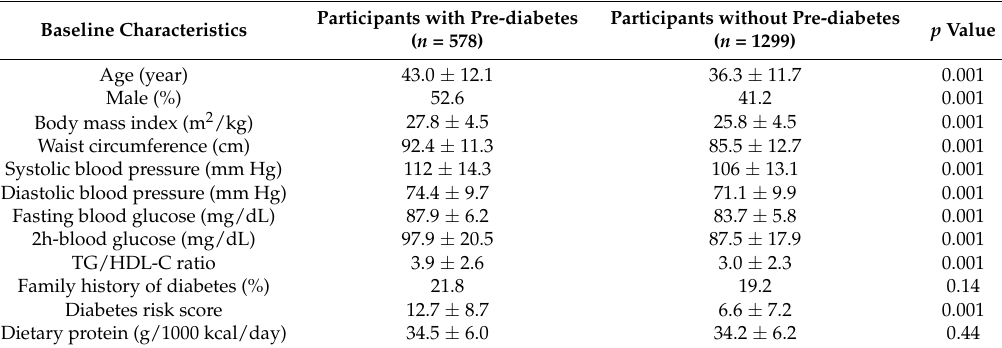
Table 1. Baseline characteristics of the participants.